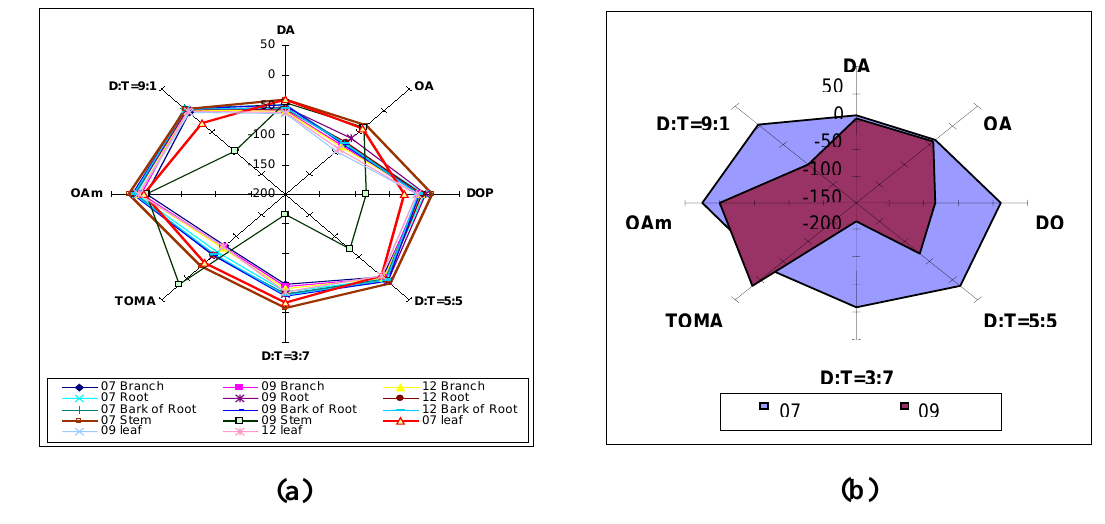
Figure 3. (a) Overall comparison of different plant parts by the relative electrical response signal intensity and (b) typical potentionmetric profile of the stem of E. longifolia from batch